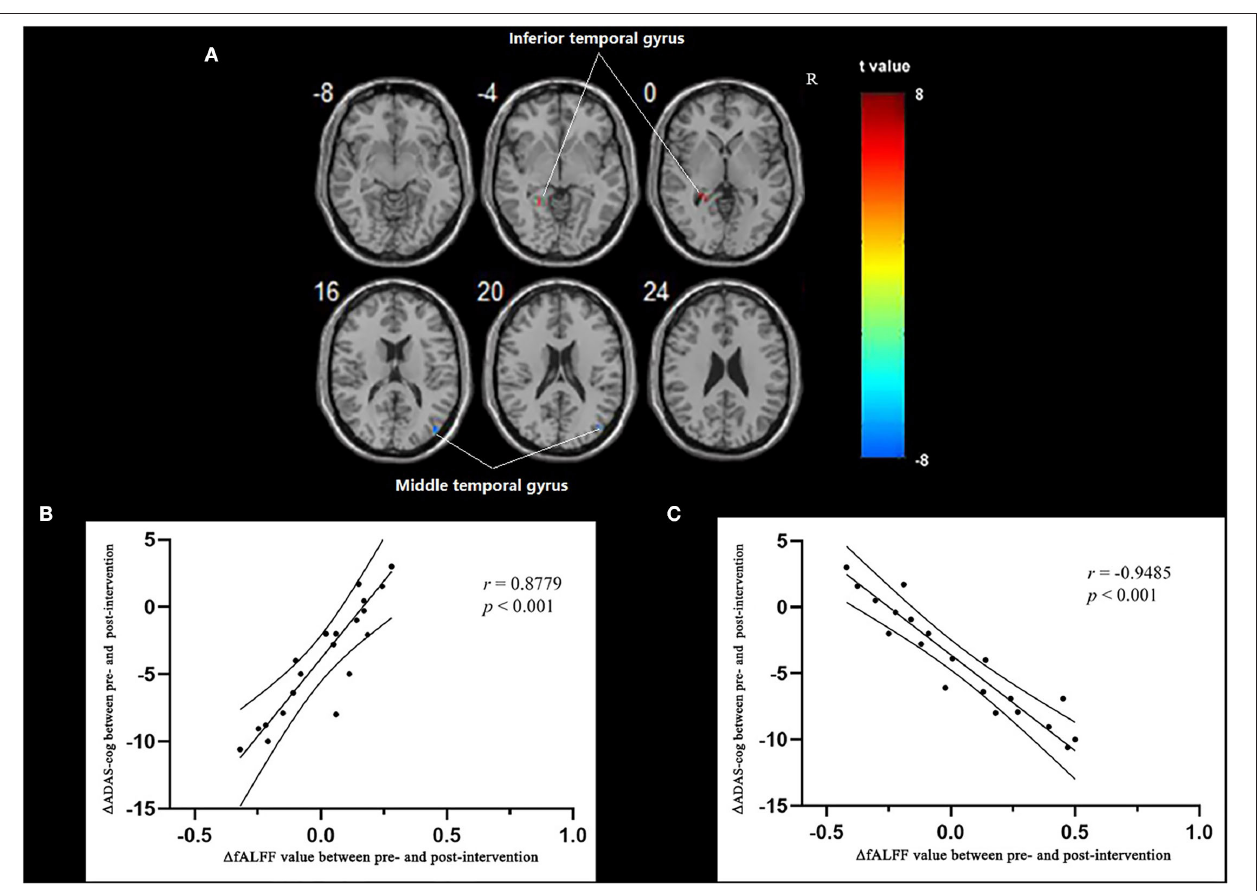
FIGURE 3 | Regions showing significant correlation in the change in fALFF in the treatment group to the change in ADAS-cog. (A) Multiple regression correlation results of significant correlation between fALFF value changes and ADAS-cog value changes in the treatment group ( p < 0.001, FWE-corrected). (B) Pearson correlation results of the change in fALFF value of the left inferior temporal gyrus and the change in ADAS-cog value. (C) Pearson correlation results of the change in fALFF value of the right middle temporal gyrus and the change in ADAS-cog